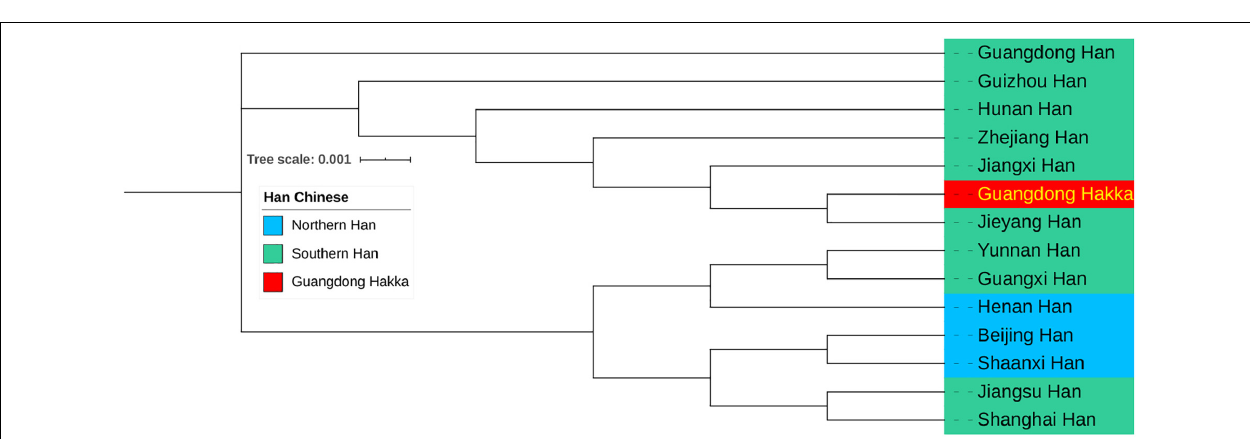
FIGURE 5 | Neighbor-joining phylogenetic tree between Guangdong Hakka and 13 Han Chinese populations (including three Northern Han and 10 Southern Han) based on the matrix of pairwise R ST